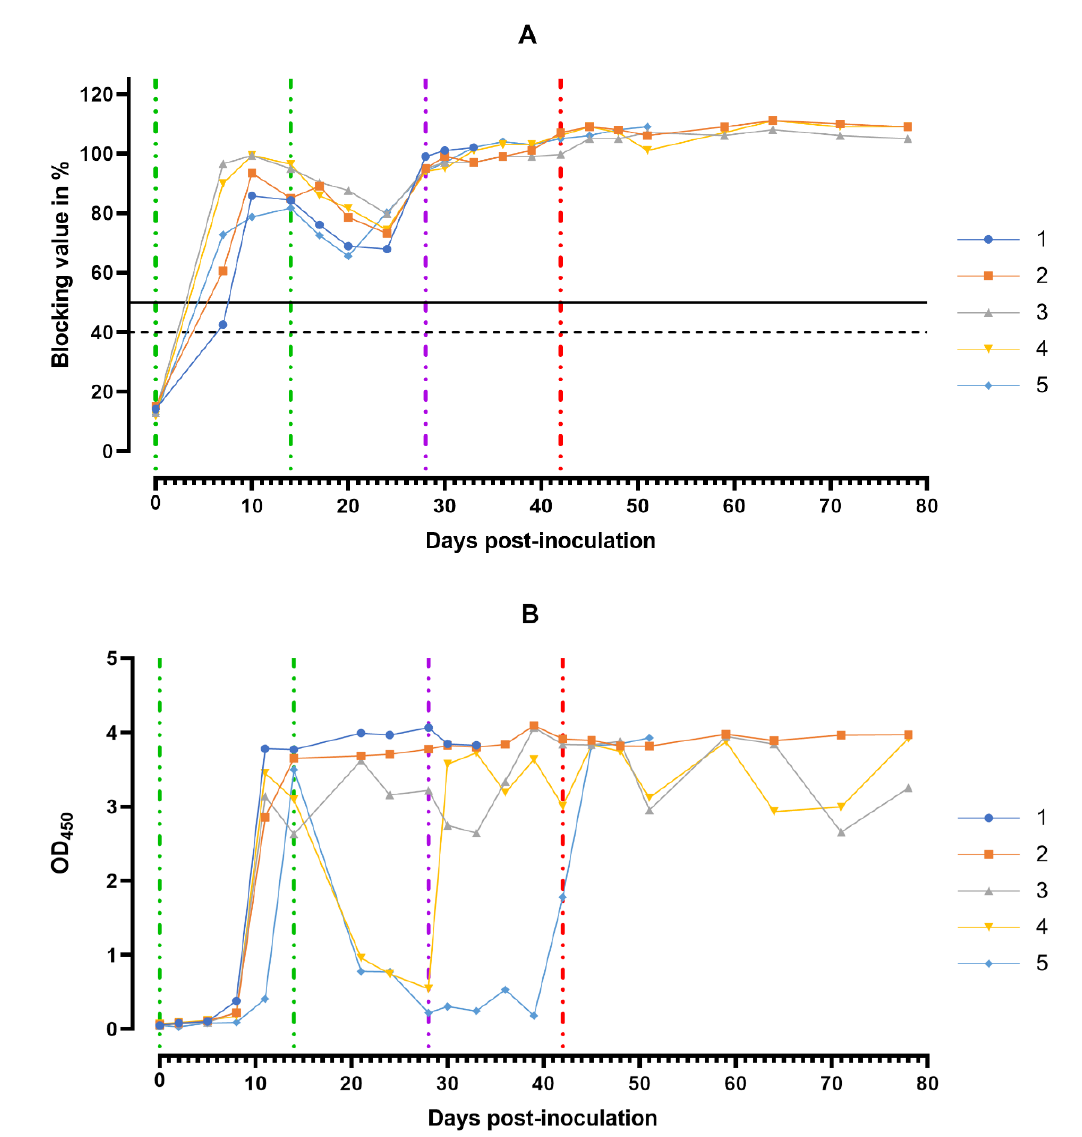
Figure 9. Anti-ASFV antibody response. Individual kinetics of ASFV-specific antibodies in serum samples ( A ) and in oral fluids ( B ) from pig group 1 (## 1 – 5) inoculated with 10 6.0 HAU 50 ASFV – Katanga-350 and challenged at a dose of 10 3.0 HAU 50 ASFV – Lisbon-57 and ASFV – Stavropol 08/01. Serum samples with a blocking percentage ≥ 50% were considered positive. Vertical dashed lines: green — days of inoculation of ASFV – Katanga-350, purple — challenge by ASFV – Lisbon-57, red — infected by the ASFV – Stavropol 08/01 strain.